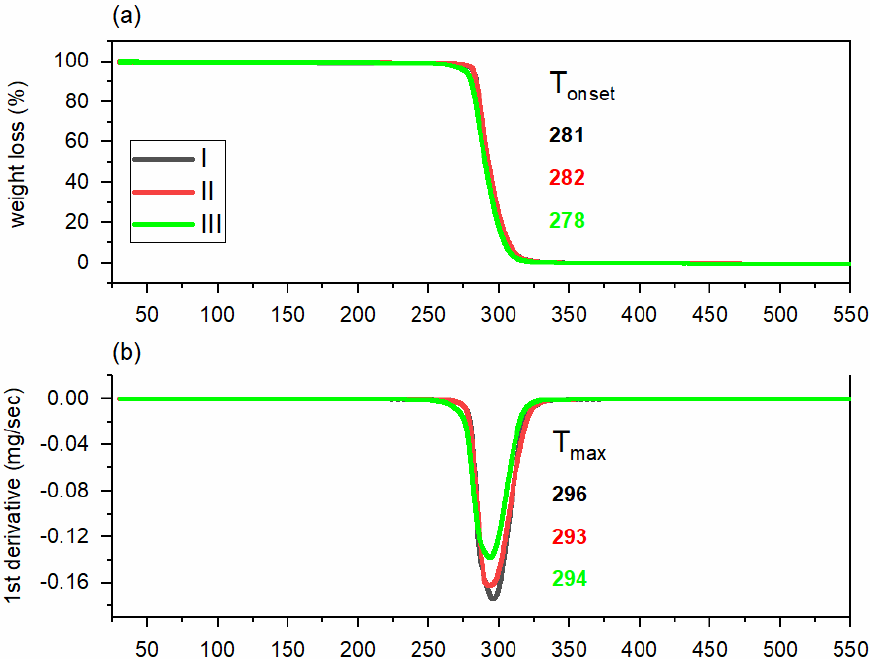
Figure 3. Thermal degradation of PHBH polymer grades; ( a ) TGA degradation curves in terms of mass loss ( b ) first derivative of TGA thermograms.